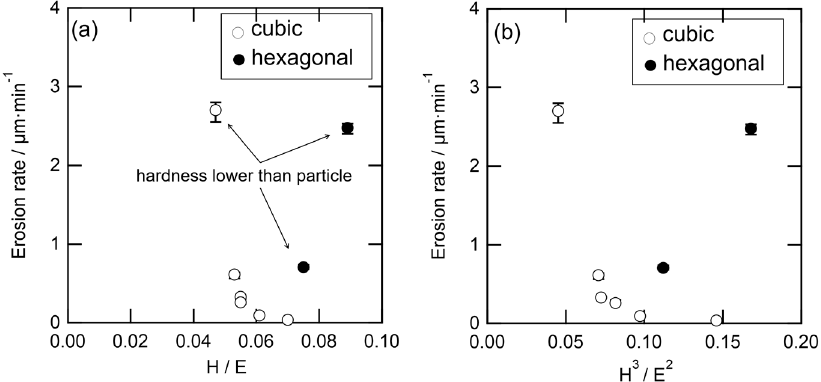
Figure 11. Relationship between ( a ) H/E or ( b ) H 3 /E 2 and erosion rate .